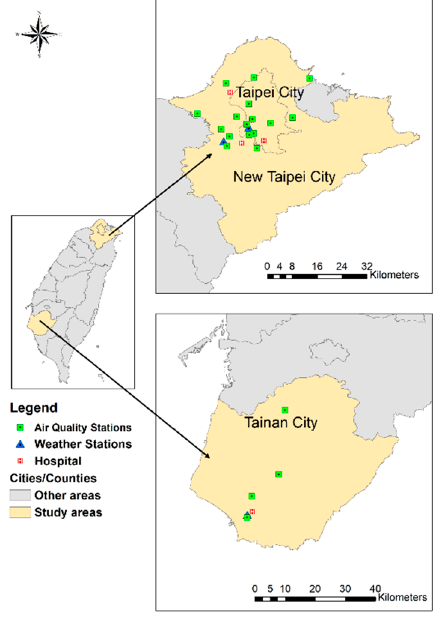
Figure 1. Geographical locations of participating hospitals and monitoring stations.